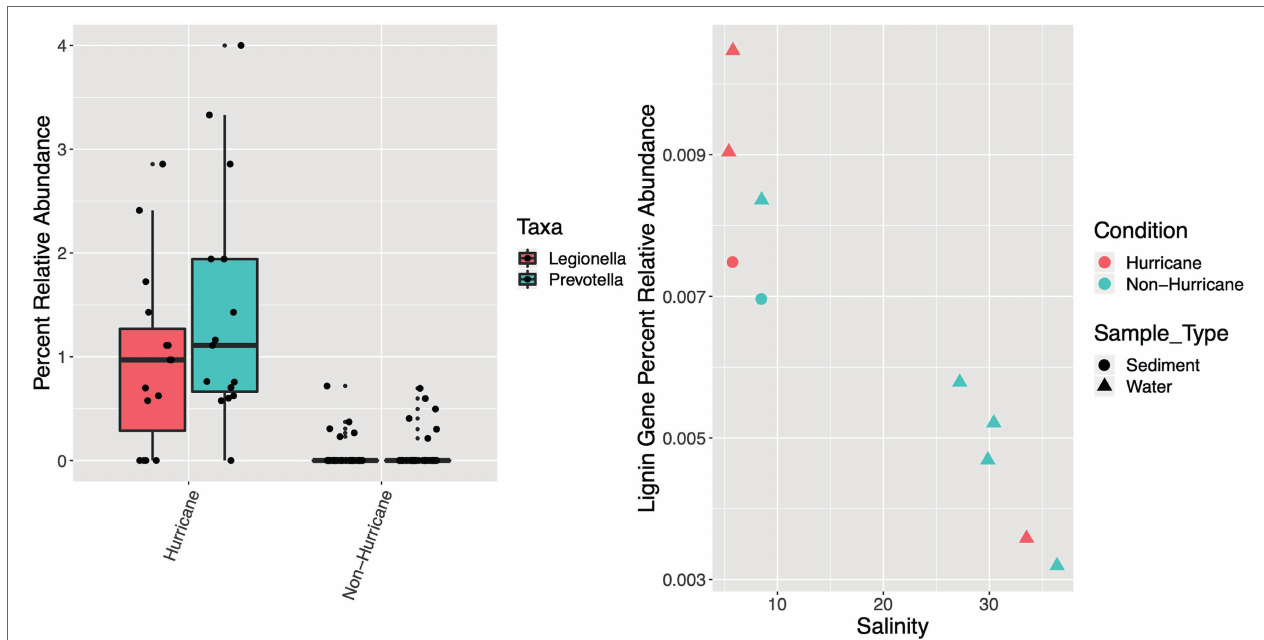
FIGURE 7 | Boxplot of percent relative abundance, or proportion of potential pathogens Legionella and Prevotella among classified genus-level taxa (left), and scatterplot of percent relative abundance of potential lignin-degradation genes across metagenomic samples (right). Hurricane condition samples contained significantly higher relative abundance of Legionella and Prevotella (mean: 1.21%; SD: 1.03%) compared to non-hurricane conditions (mean: 0.05%; SD: 0.15%; Mann–Whitney U-test: W = 261.5, p <